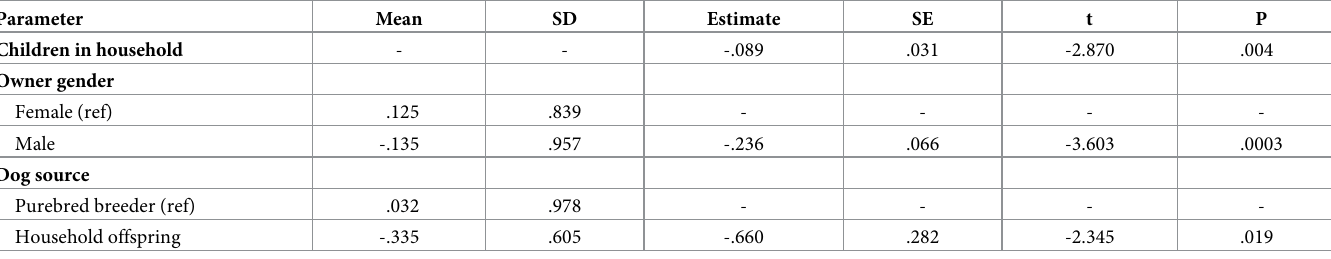
Table 9. Statistically significant interactions of owner and dog parameters on HAB Factor 2